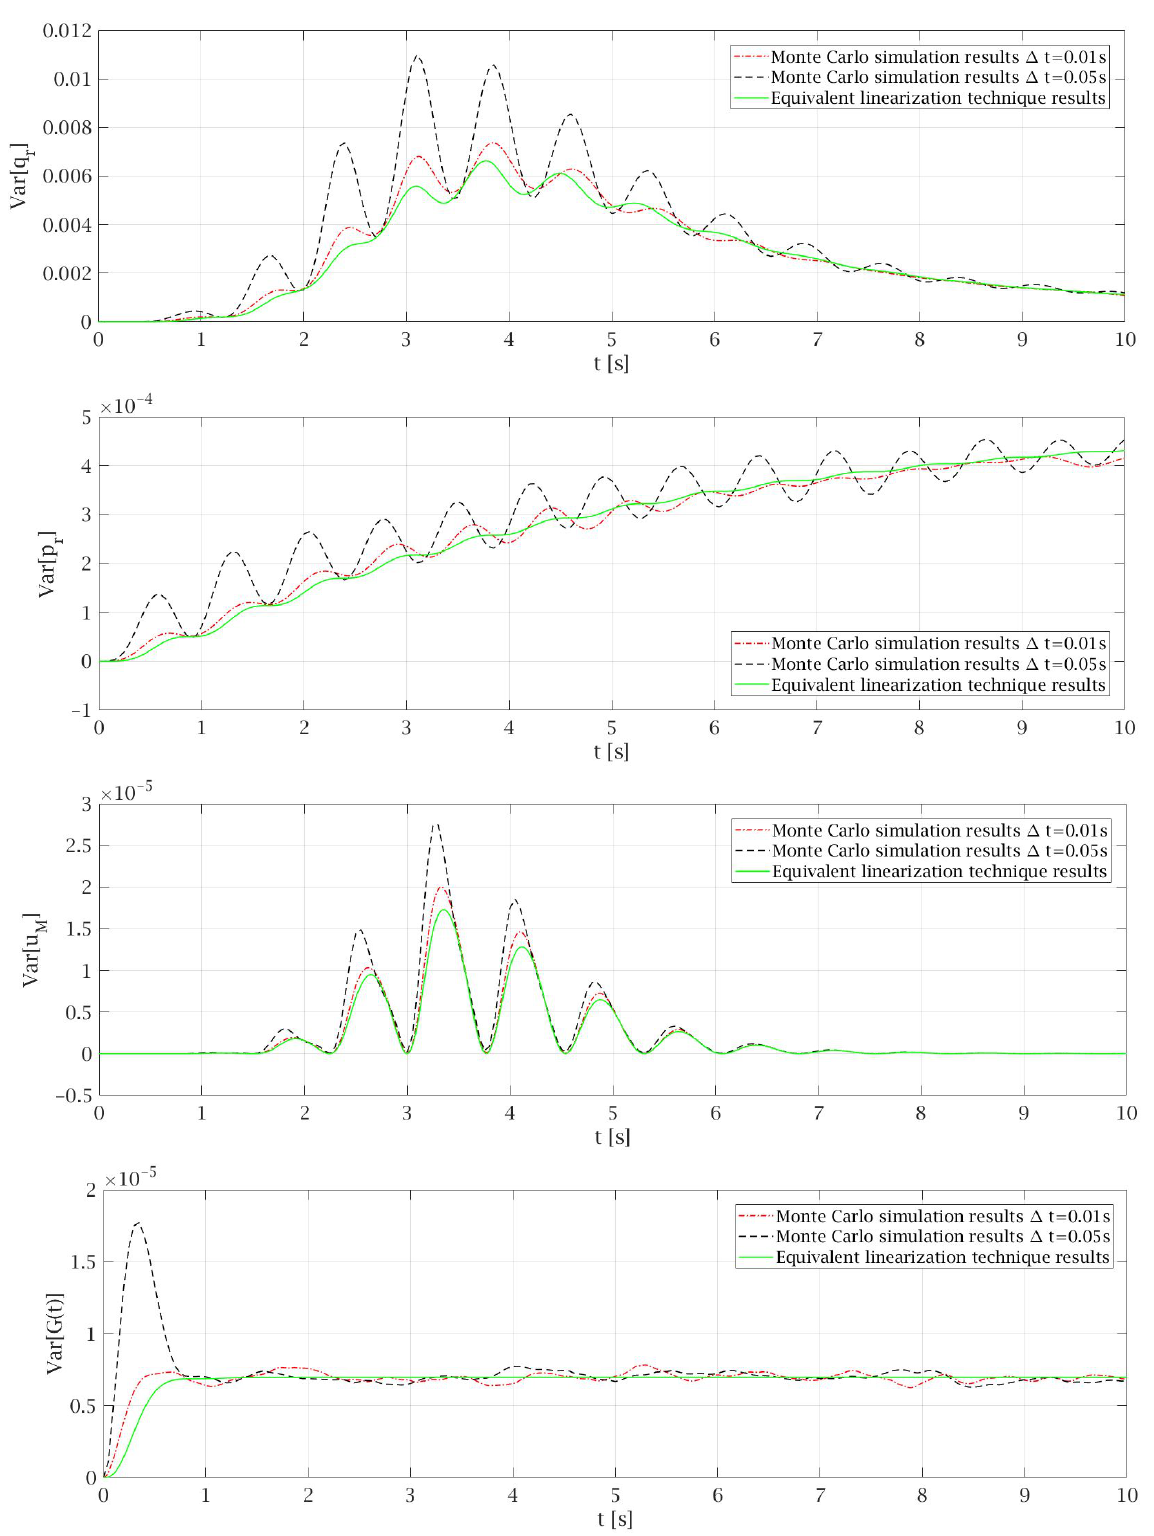
Figure 7. Selected details of the variances of particular random state variables obtained for P = 1.87 × 10 − 4 and ζ s =